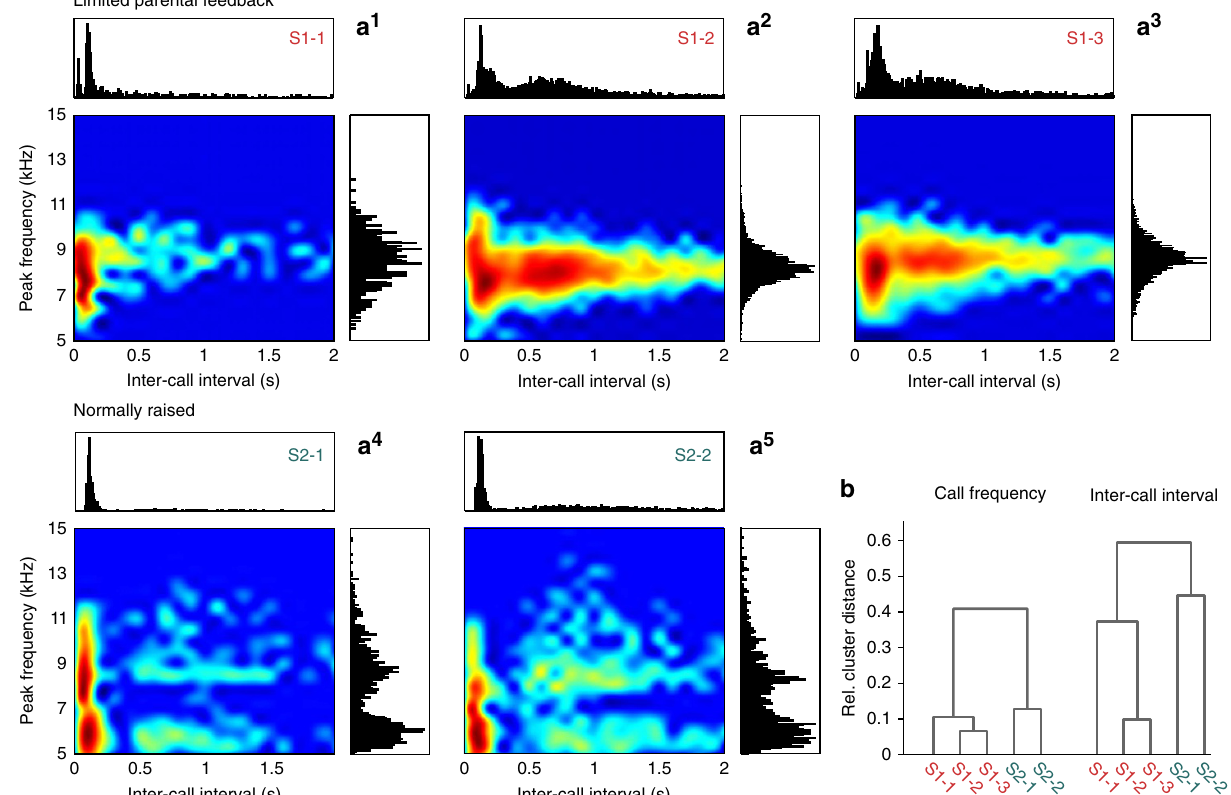
Figure 2 | Differences in peak frequency and inter-call intervals between S1 and S2 monkeys. ( a ) Logarithmic probability maps of peak frequency and inter-call interval for S1 ( a 1 – a 3 ) and S2 siblings ( a 4 and a 5 ). Warmer colours in the heat maps indicate higher probabilities (lower left panel in a 1 – a 5 ). Histograms show absolute distribution of peak frequencies (right panel in a 1 – a 5 ) and inter-call intervals (upper panel in a 1 – a 5 ). ( n ¼ 13,582 vocalization for peak frequencies and n ¼ 11,370 vocalizations for inter-call intervals) ( b ) Clustering dendrogram of the five monkeys based on call frequency and inter-call interval (weighted linkage method with Spearman’s proximity